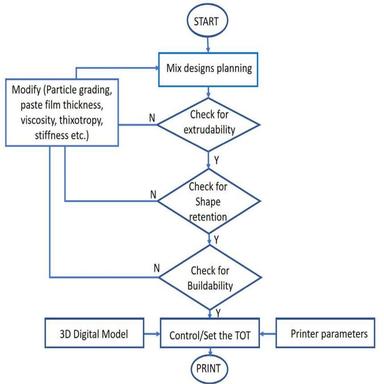
perimental methods for 3D printable material